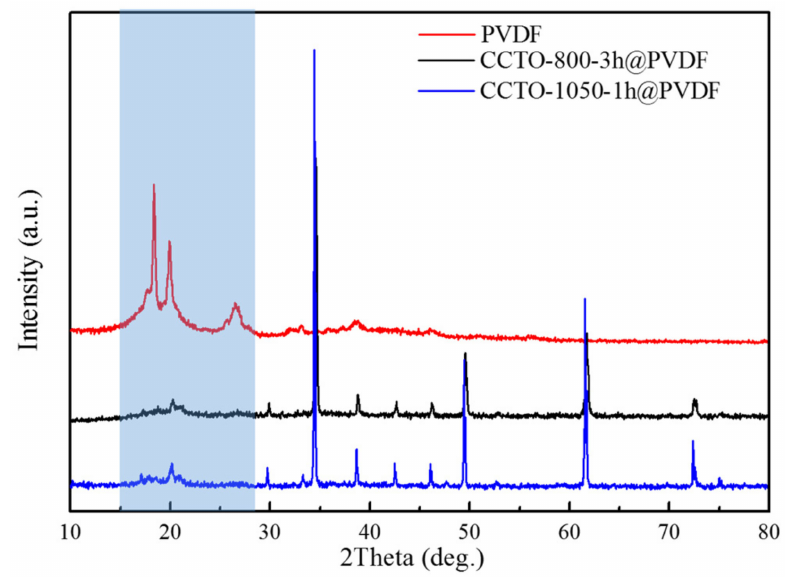
Figure 7. XRD patterns of CCTO@PVDF composites with different CCTO (40